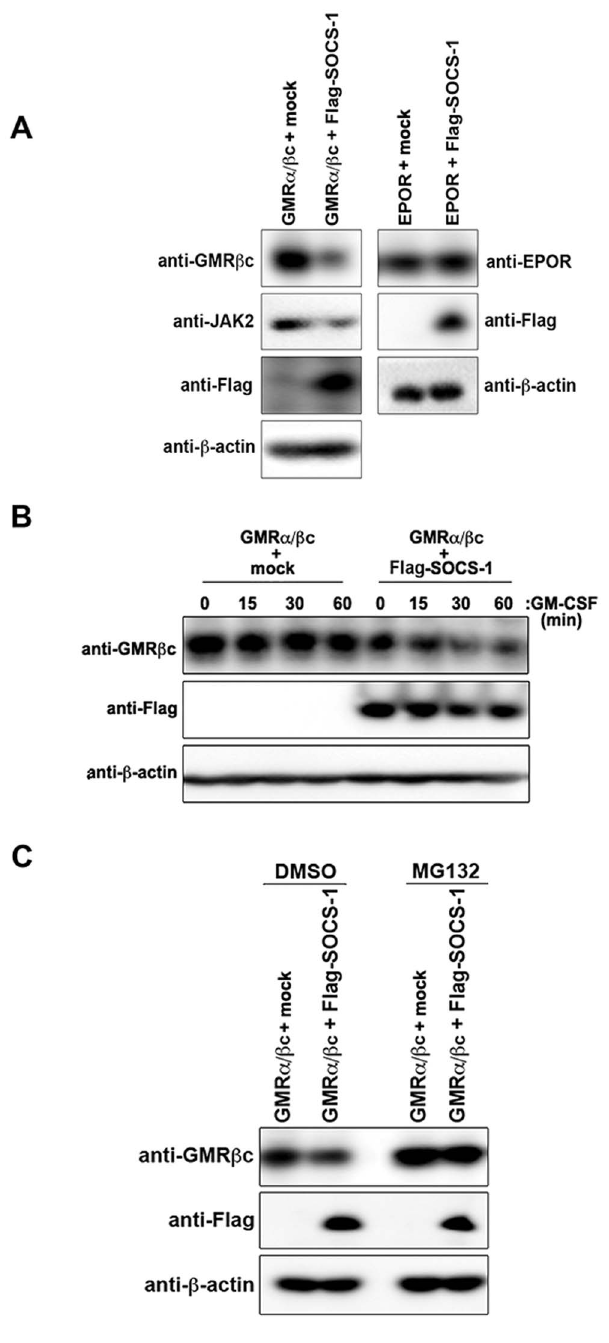
Figure 1. SOCS-1 decreases GMR b c expression level in a proteasome-dependent manner. (A) HEK293 cells transfected with plasmids encoding GMR a and b c (left panel) or EPOR (right panel) with or without Flag-SOCS-1 or empty plasmid (mock) were lysed and immunoblotted with the indicated antibodies. (B) HEK293 cells transfected with plasmids encoding GMR a and b c with or without Flag-SOCS-1 or empty plasmid (mock) were serum starved, stimulated with GM-CSF for indicated times and lysed for immunoblotting with the indicated antibodies. (C) HEK293 cells transfected with plasmids encoding GMR a and b c with or without Flag-SOCS-1 or empty plasmid (mock) were treated with MG132 or DMSO for 4 h prior to cell lysis and immunoblot analysis using the indicated antibodies.